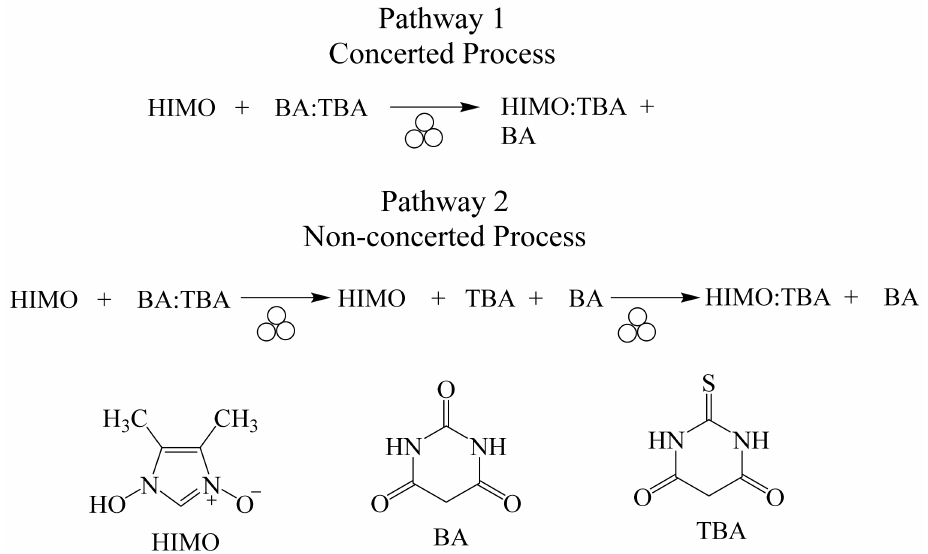
Figure 10. Schematic representation of the two proposed mechanisms behind the formation of